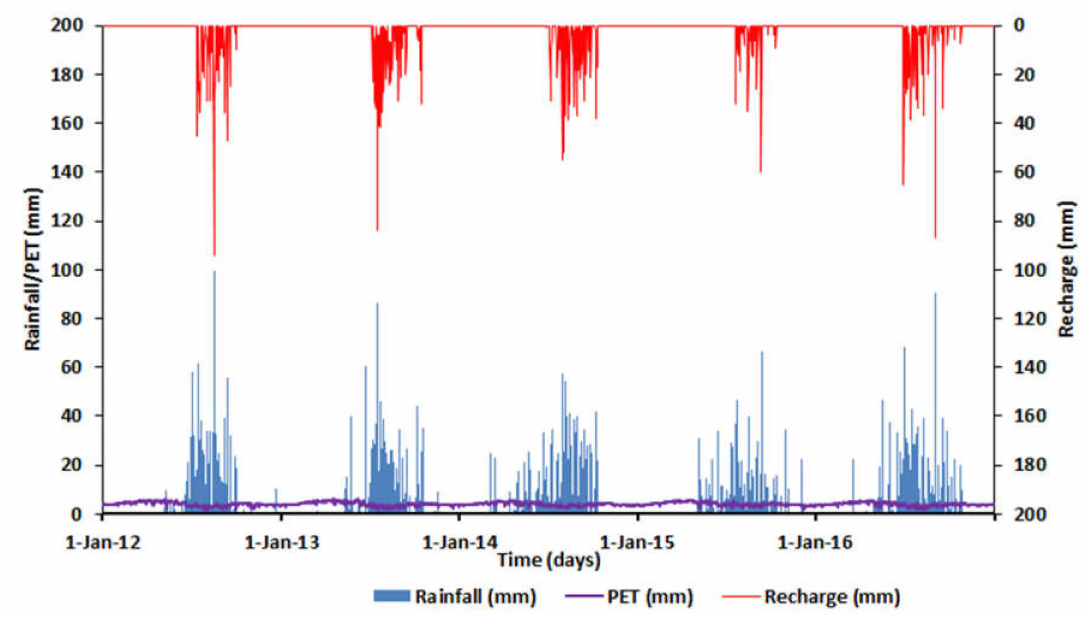
Figure 8. Daily rainfall (Bahir Dar Meteorological Station), potential evapotranspiration (PET) and calculated groundwater recharge (Soil Moisture Balance—SMB method) for the period